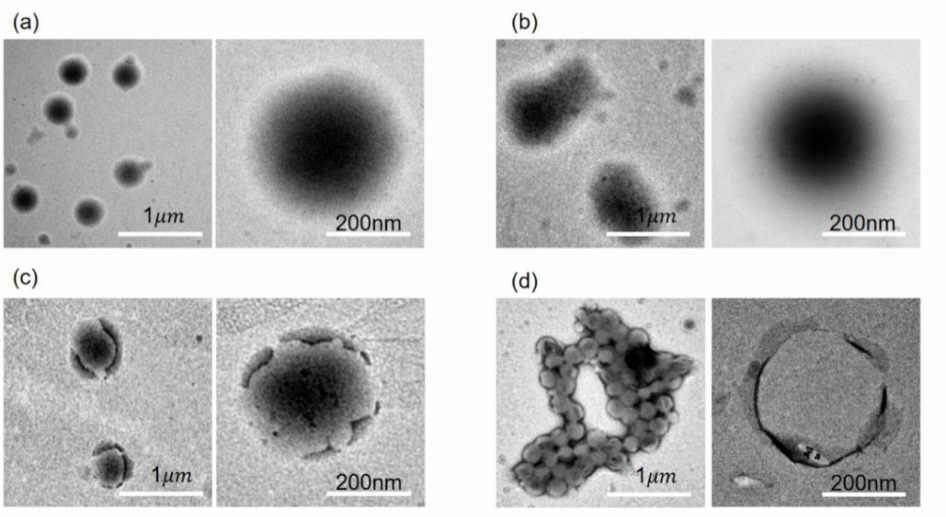
Figure 5. TEM images of polyacrylate latex stabilized by different stabilizers: ( a ) SDS, ( b ) hectorite-